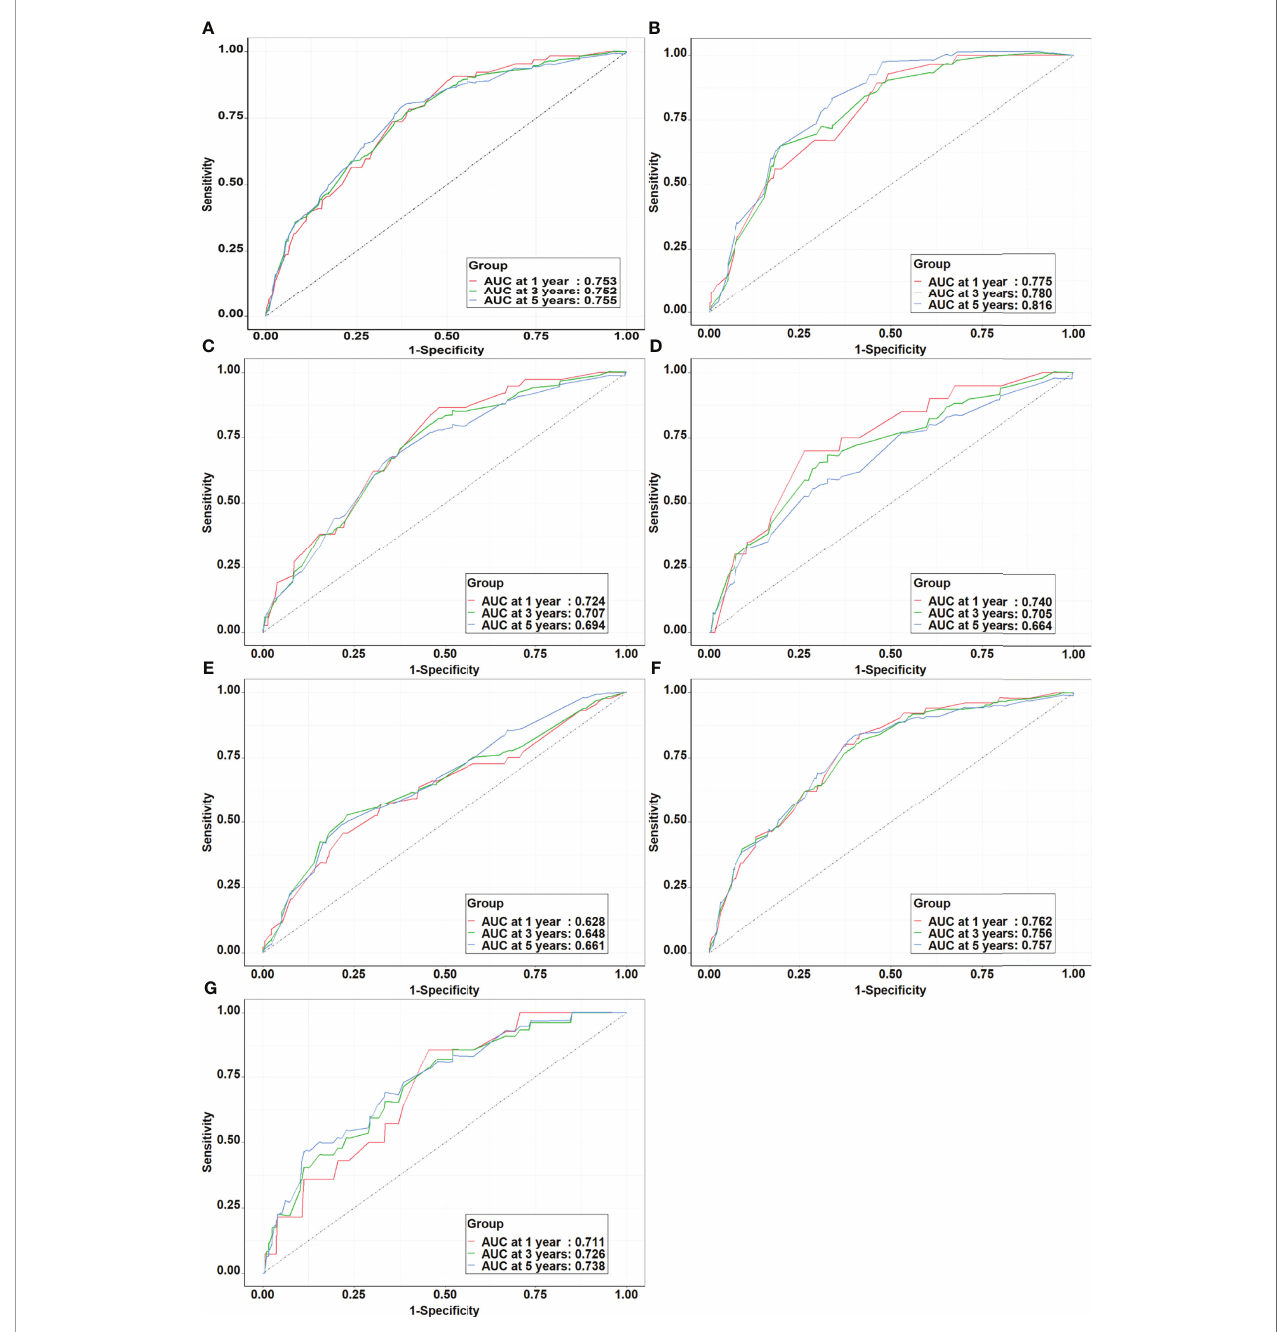
FIGURE 3 | The receiver operating characteristic curves of prediction models in the training set. (A) Whole population; (B) Male; (C) Female; (D) Age<60 years; (E) Age ≥ 60 years; (F) Non-passive smokers; (G) Passive